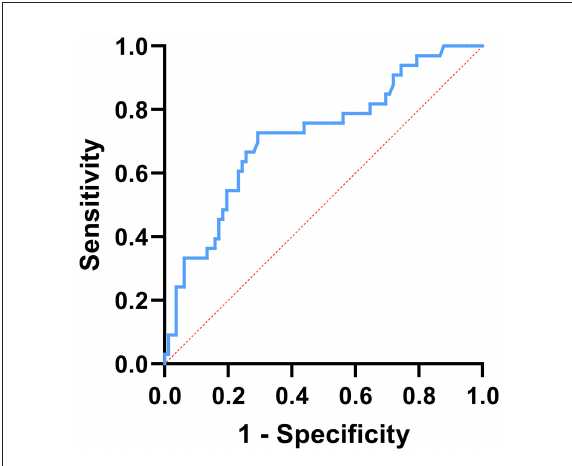
FIGURE1 ROC curve analysis of the prediction for the following recurrent seizure attacks based on NLR1. The best cut-off value of NLR1 was 5.56, area under the curve (AUC) = 0.717, P < 0.001, 95% CI: 0.611–0.823, sensitivity: 73%, and specificity: